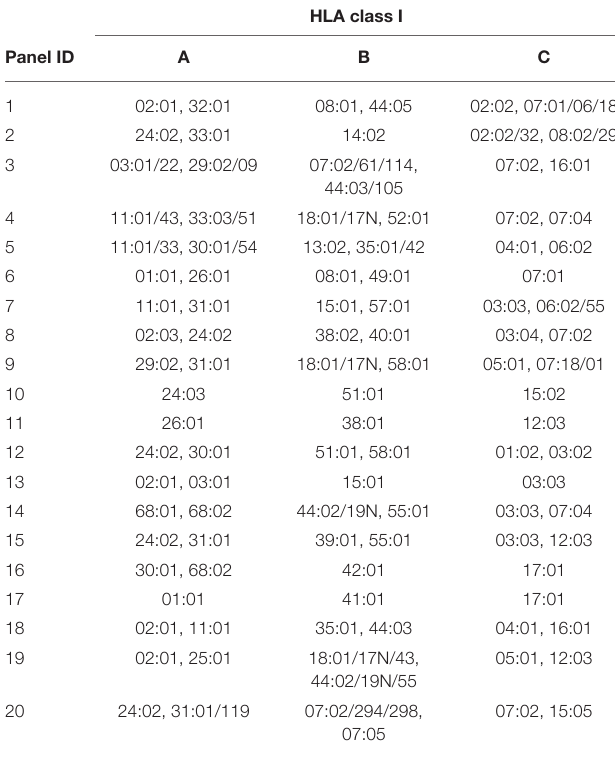
TABLE 4 | HLA class I typing of the EBV-LCL panel.